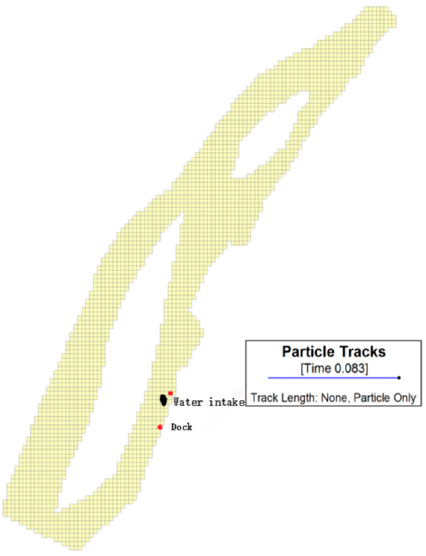
Figure 4. Influence range of oil slick drift in an oil spill accident (when the oil slick reaches the water intake).